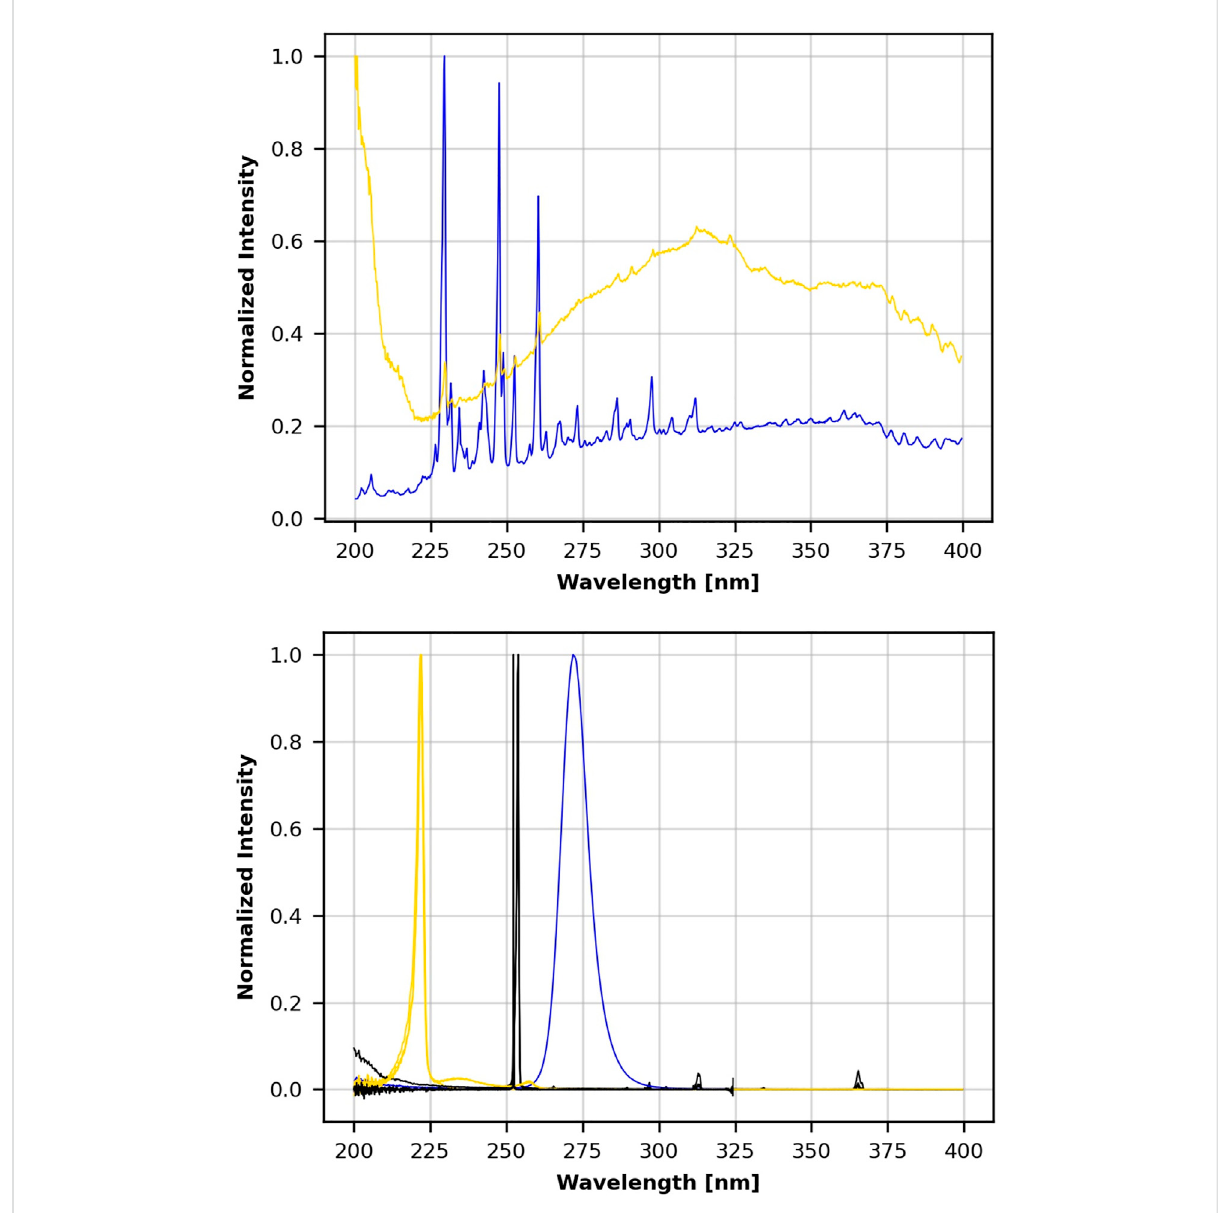
FIGURE 2 Normalized wavelength emission spectra for 14 UV devices. Top frame shows Xenex ( ) and pulsed xenon ( ) emission. Lower frame shows the emission for three 222 nm emitters ( ), eight 254 nm emitters ( ), and the 272 nm emitter (